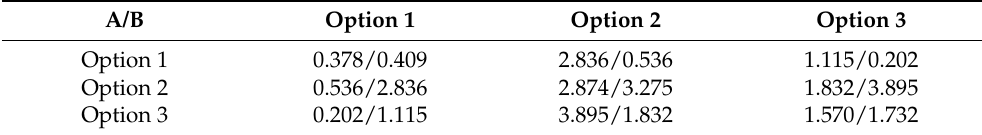
Table 10. Median payoffs of option contest (USD